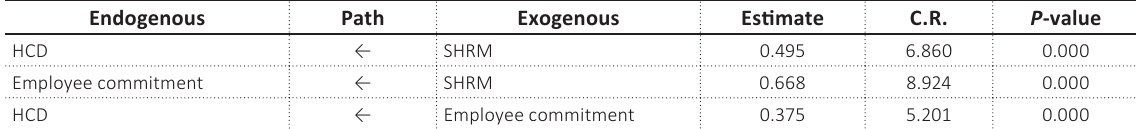
Table 7. Regression path and significance